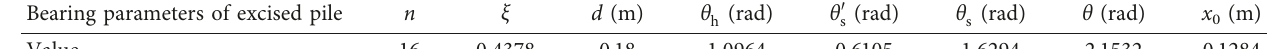
Table 4: Section bearing parameters of the excised pile.